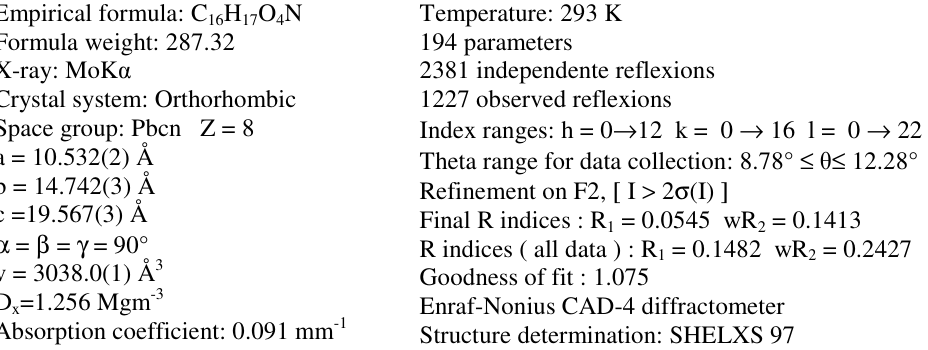
Table 1. Crystal, data collection, and structure refinement